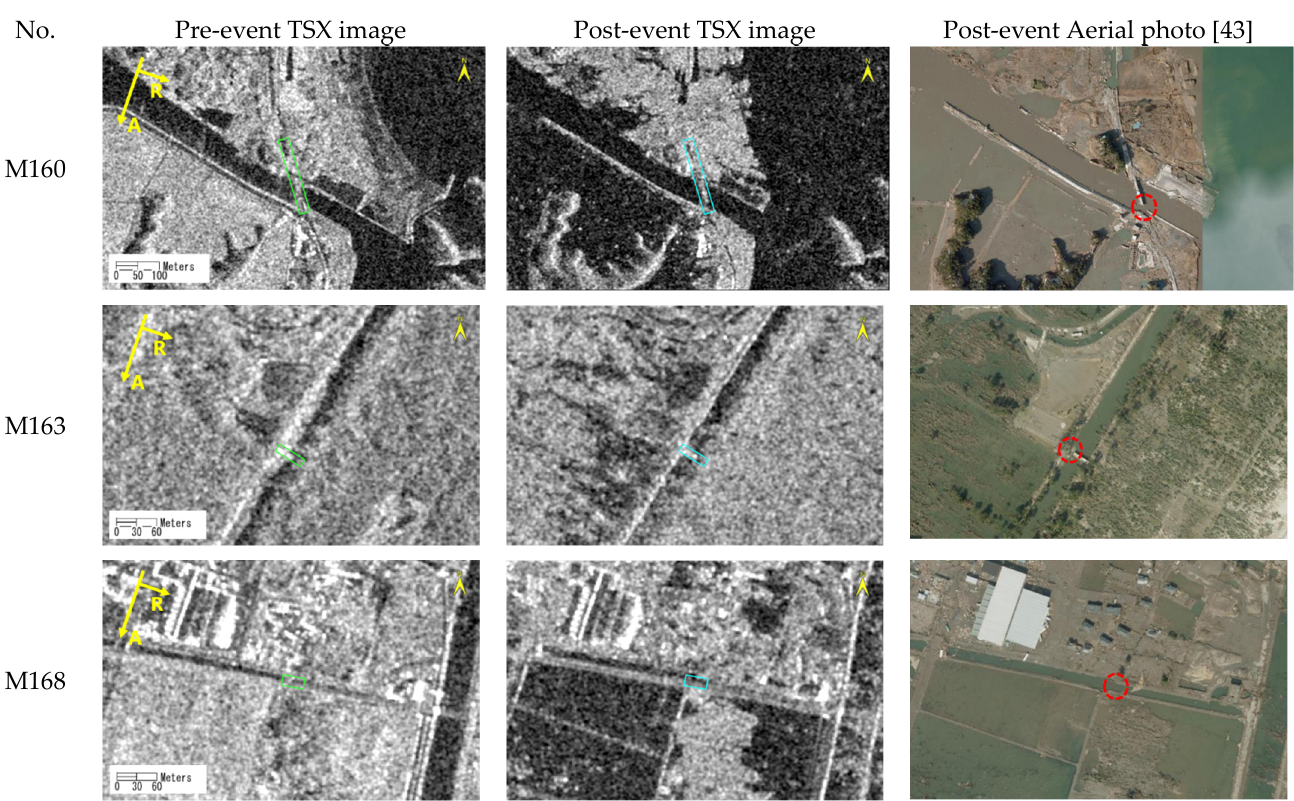
Figure 6. Three partly collapsed or washed-away bridges that could not be identified by the best RF model using five features for the data set 2 [43].